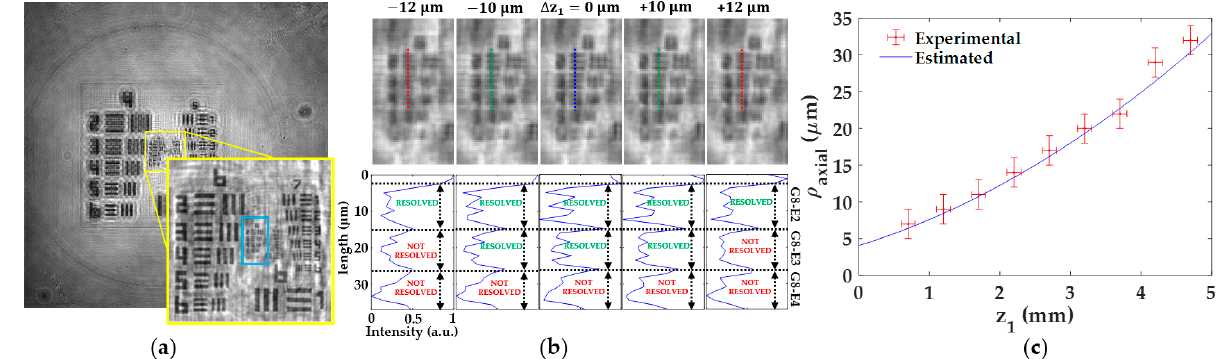
Figure 6. Analysis of the axial resolution of the lensless holographic microscope. ( a ) Best focused image for the case of z 1 = 3.2 ± 0.1 mm. ( b ) Propagated images (upper part) of the region enclosed in the blue rectangle included in ( a ) and its corresponding intensity profiles along the dashed lines. ( c ) Calibration curve of the axial resolution including both experimental and expected values.